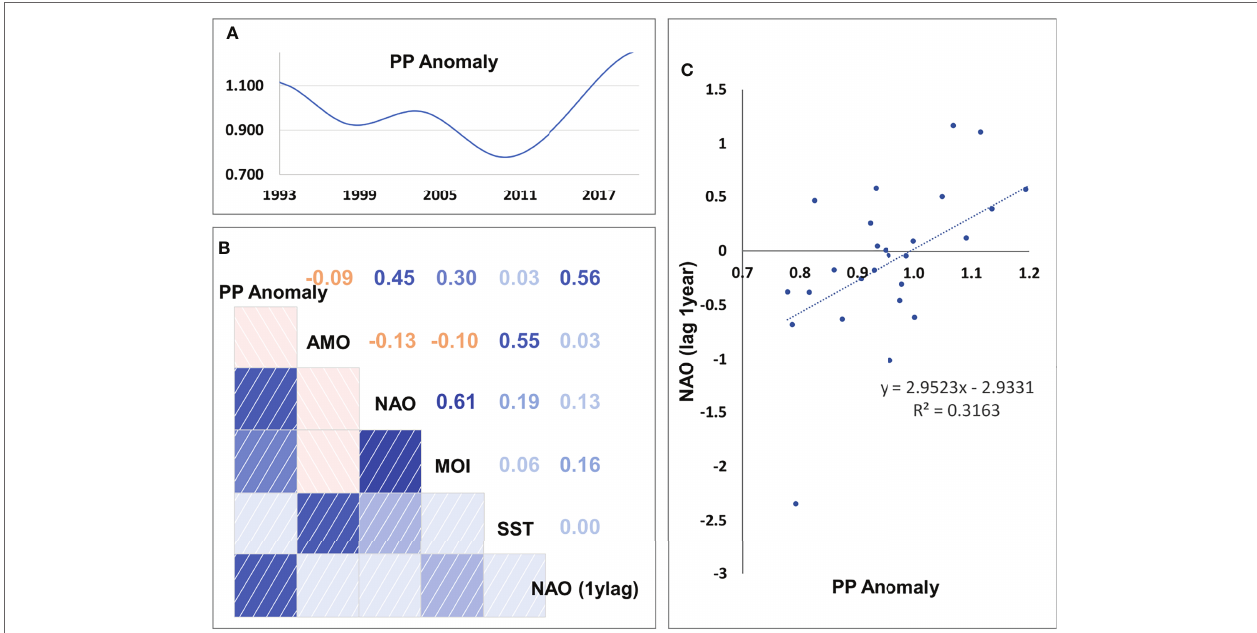
FIGURE 5 | (A) Estimated values of PP Anomaly, (B) correlation coefficients among PP Anomaly, Sea Surface Temperature (SST) and climatic indices (MOI, Mediterranean Oscillation Index; AMO, Atlantic Multi-decadal Oscillation; NAO, North Atlantic Oscillation; NAO (1ylag), NAO with lag of 1 year), and (C) scatterplot of annual mean PP Anomaly and NAO with lag of 1 year.